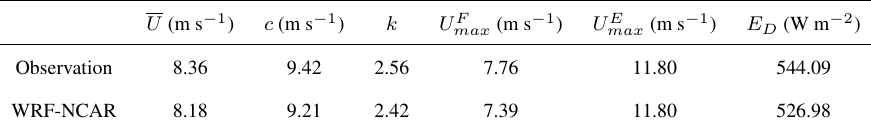
Table 3. Comparison of the observed and the WRF-NCAR model forecast-derived wind speed related statistics at Sweetwater, TX (100 m AGL). Study period: April, 2006–March, 2007.